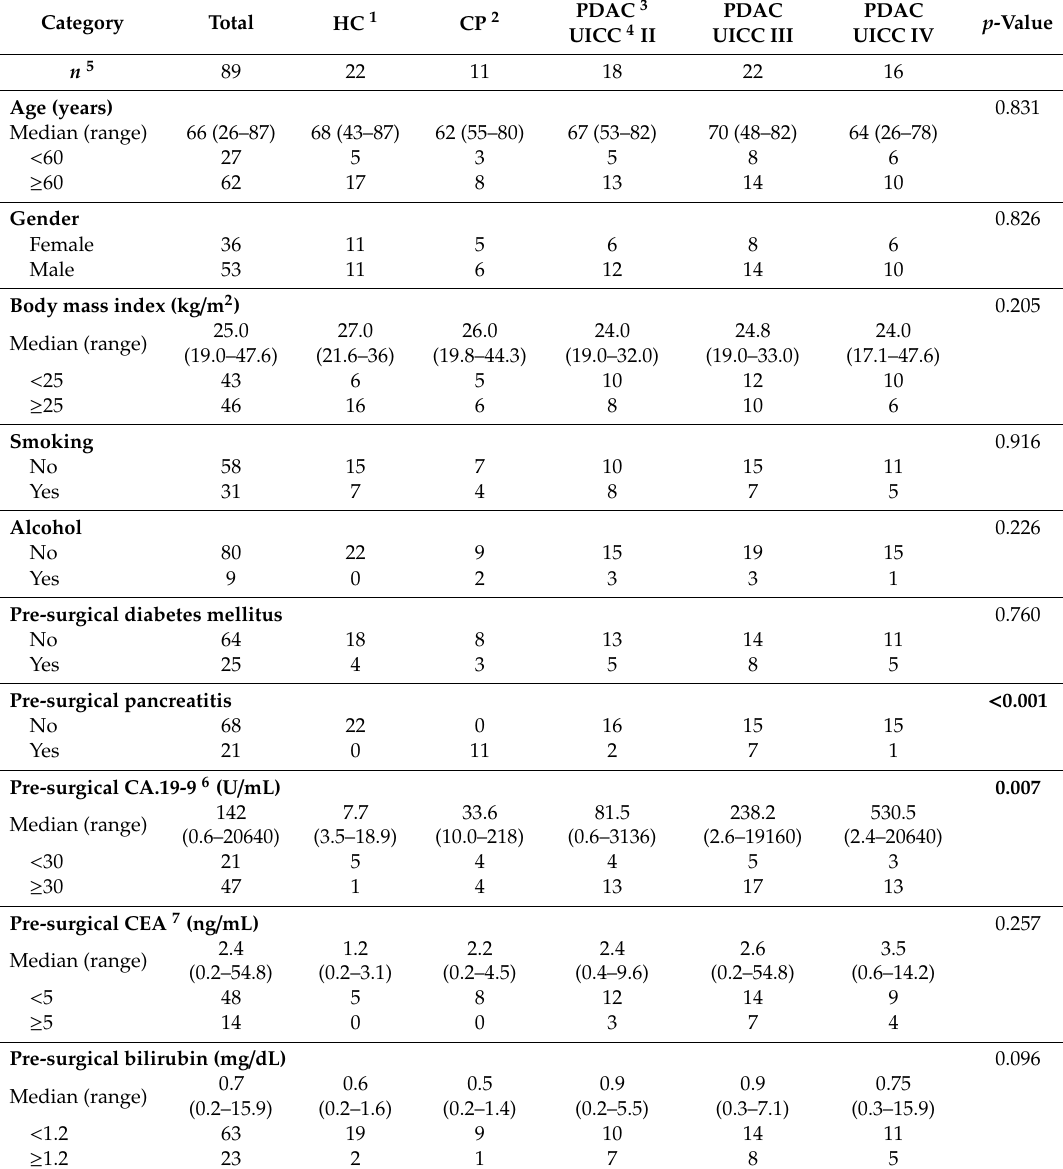
Table 1. Clinicopathologic data of all patients included in the